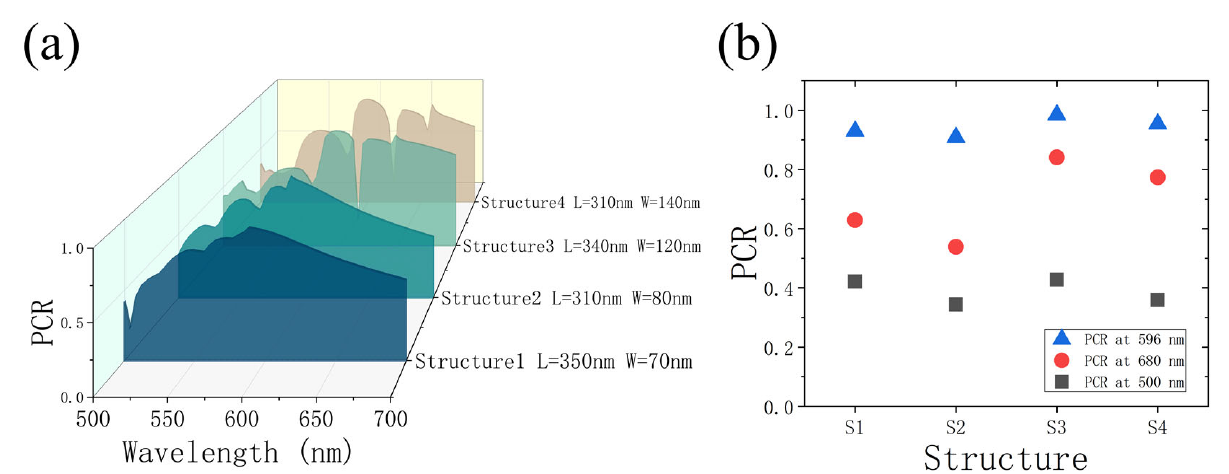
Figure 6. ( a ) Polarization conversion rate of the selected nanobricks under CP light ranging from 500 nm to 700 nm. ( b ) Polarization conversion rate of the nanobricks at 596, 680, and 500 nm respec ‐ tively.